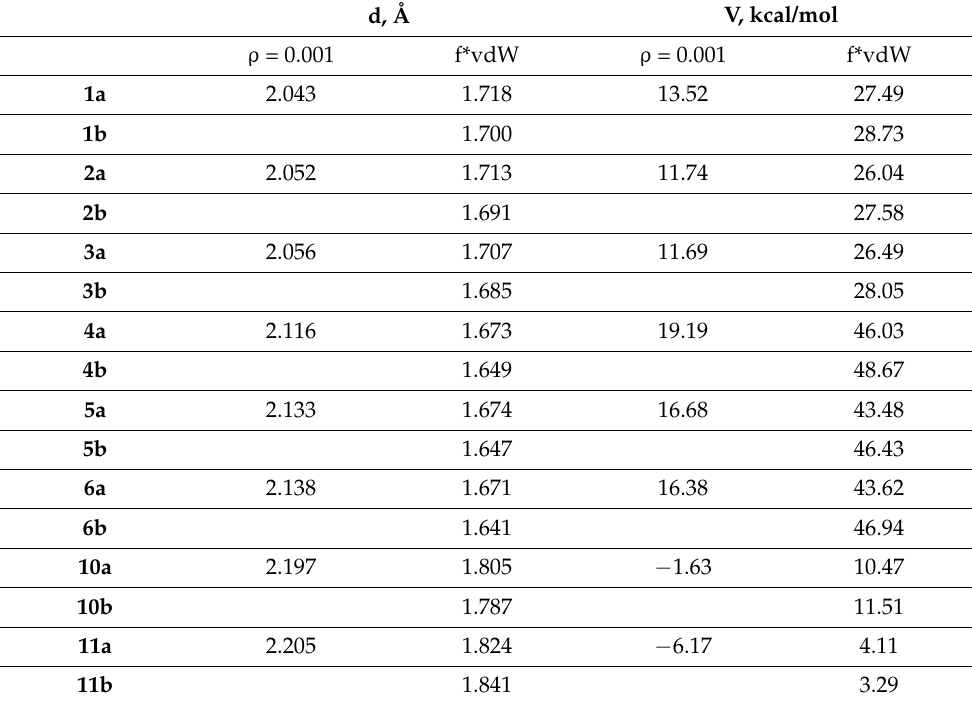
Table 10. Distances of points for evaluating MEP from Ch atom, and value of MEP at that point. d, Å V, kcal/mol ρ = 0.001 f*vdW ρ =